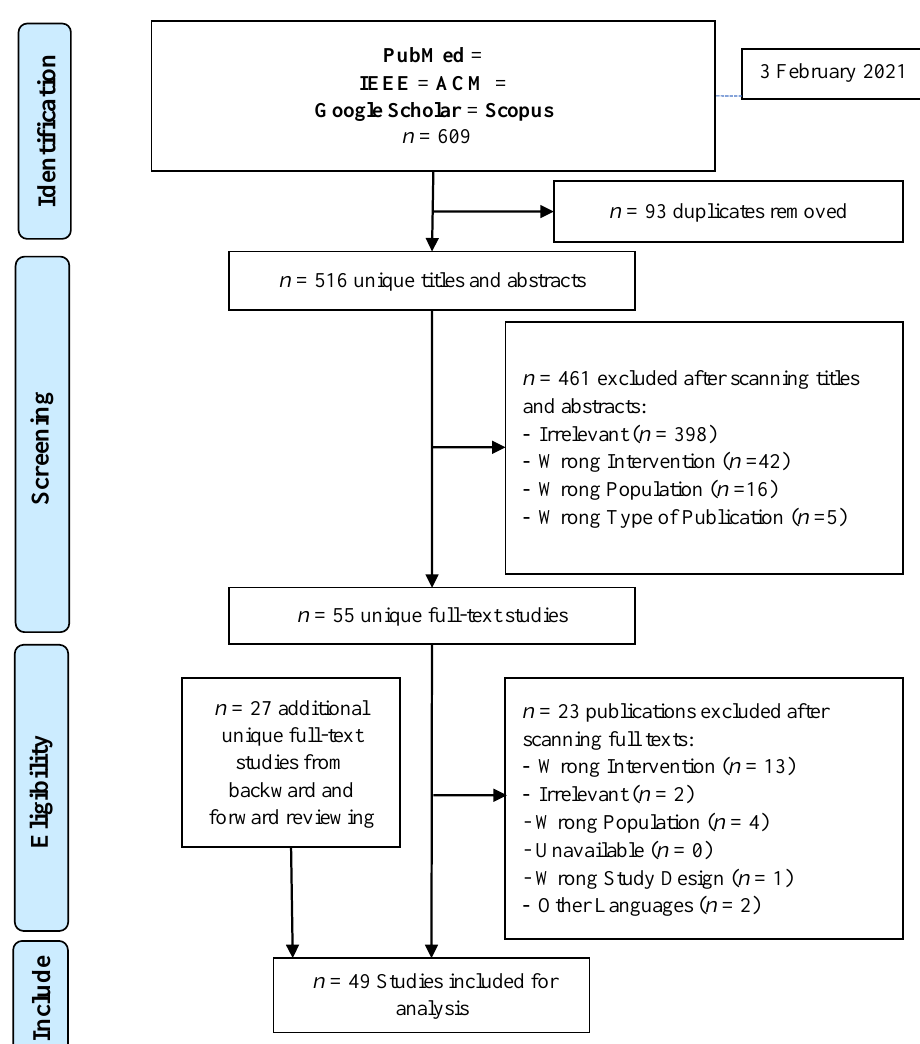
Figure 5. PRISMA diagram for study selection.